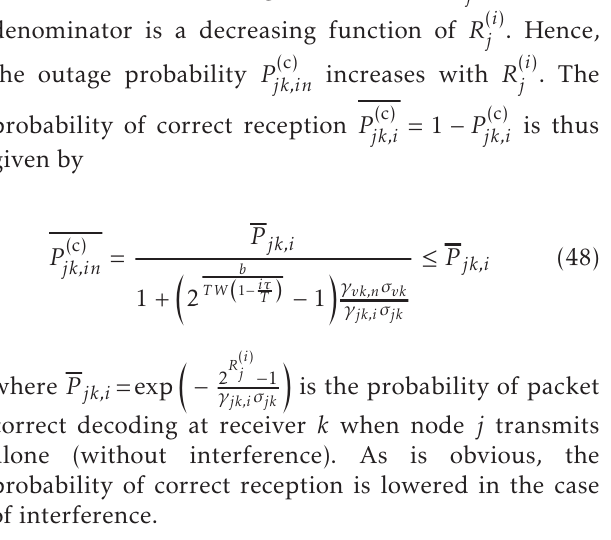
Figure 8. Maximum secondary throughput versus energy arrival rate.